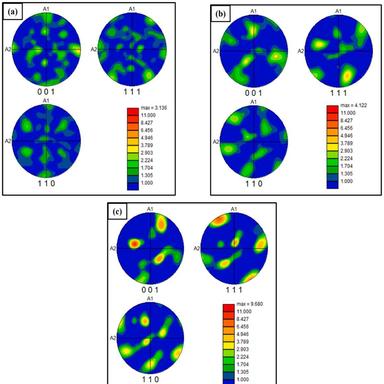
EBSD pole figures of (a) Base, (b) WOR_3, and (c) WR_3 materials.